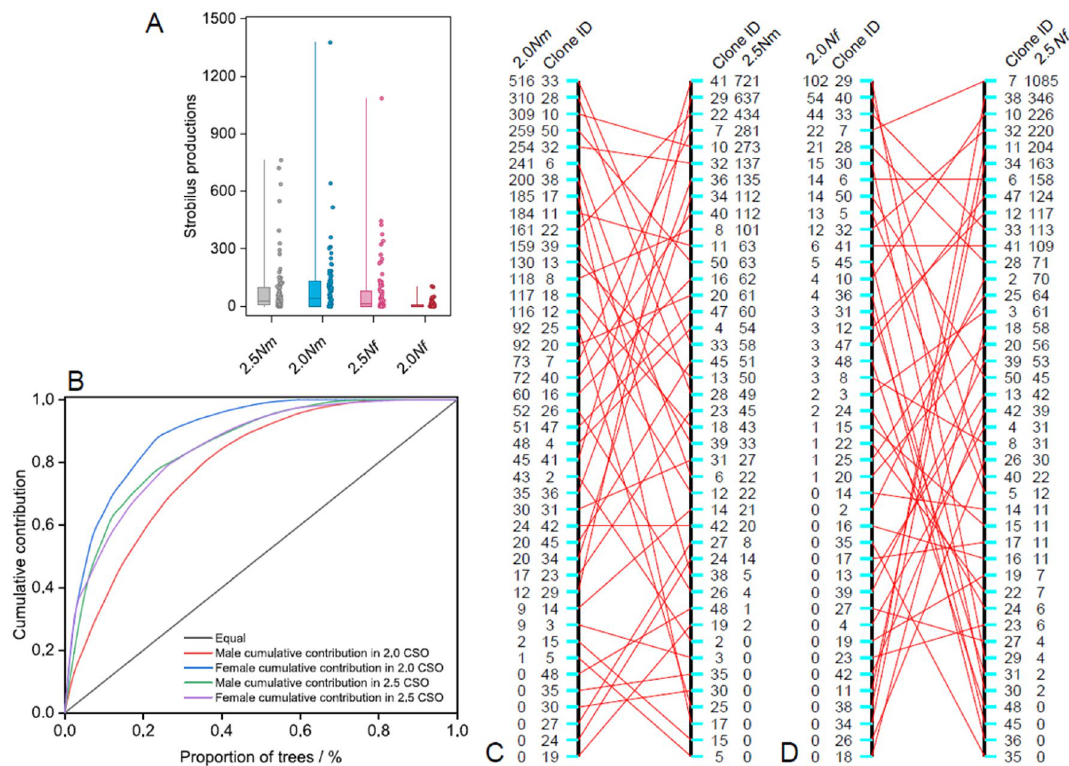
Figure 1. Fertility variation of strobili production in two generations seed orchards of Chinese fir. ( A ) The female and male strobili production for two seed orchards, ( B ) the parental-balance of female and male strobili production in the seed orchards for CSO2 and CSO2.5, ( C , D ) the rank order for 42 clones based on average female and male strobili production in two seed orchards. 2.0 Nm and 2.0 Nf show the female and male strobili production in CSO2, respectively. Correspondingly, 2.5 Nm and 2.5 Nf refer to the female and male strobili production in CSO2.5, respectively.